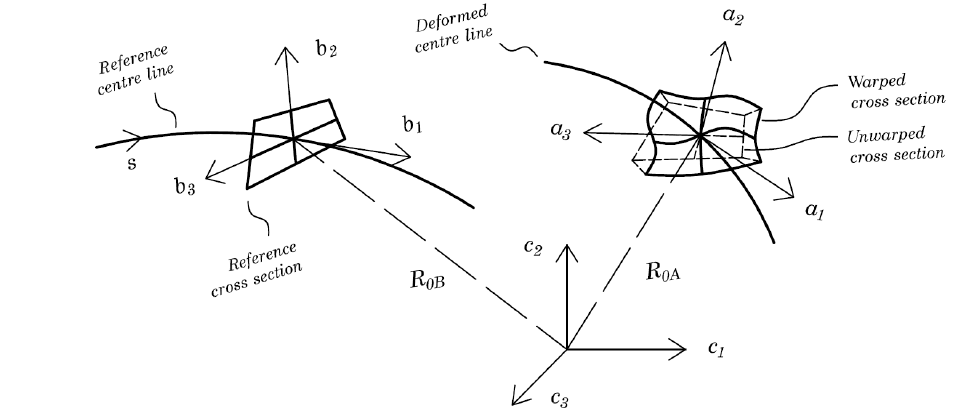
Figure 1. Schematic of the reference and current states, centre lines, cross sections, and local frames.